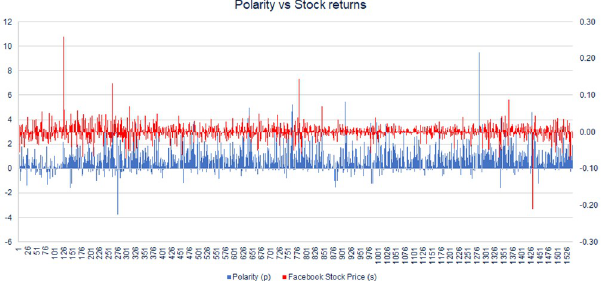
Fig 2. Time series of daily returns of Facebook vs Facebooks’ Sentiment Index. It can visually be appreciated the synchronized upward or downward movements between the Sentiment Index and the company performance.